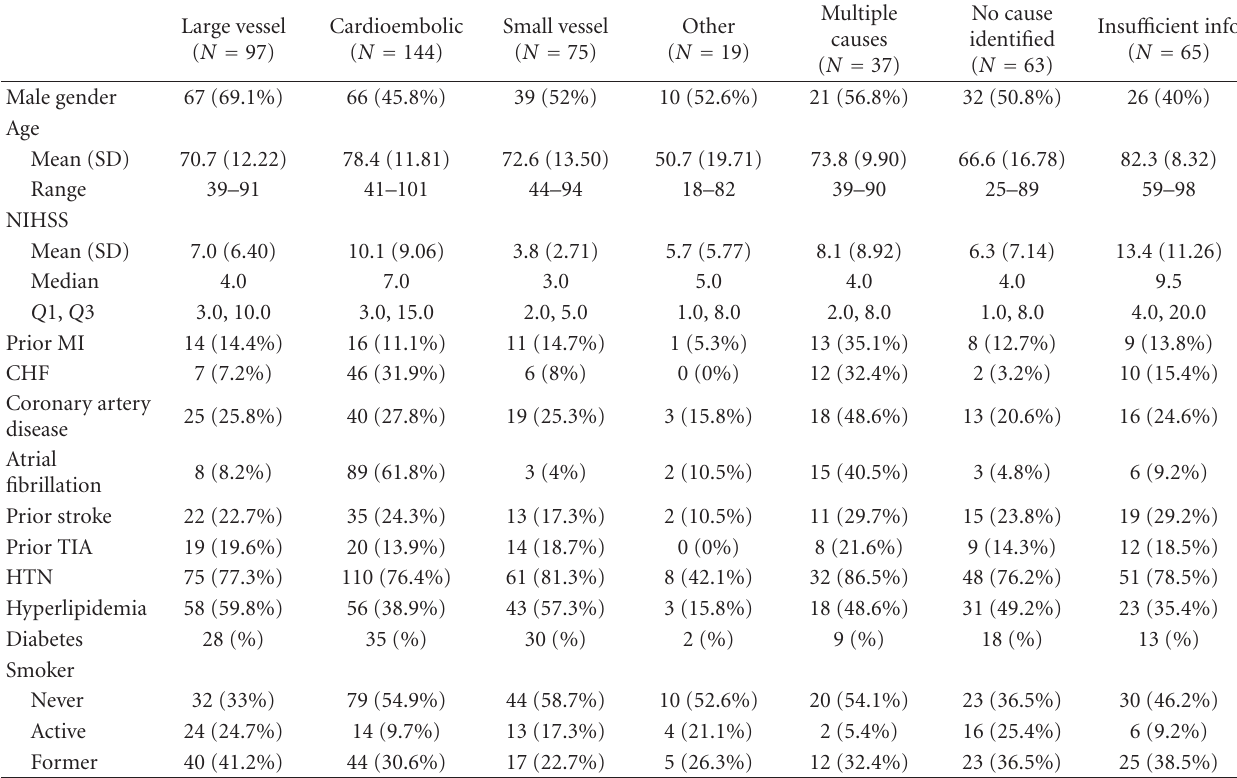
Table 1: Summary of patient characteristics by TOAST classification.